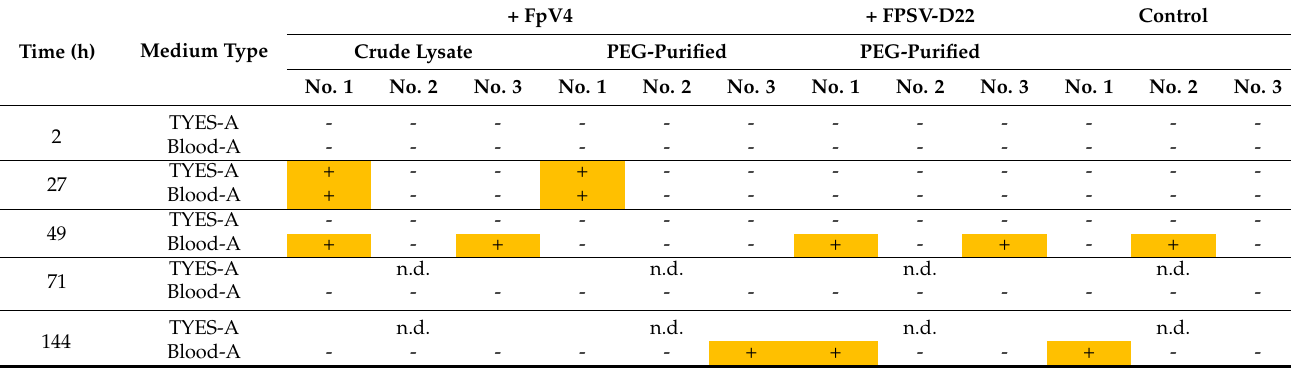
Table A3. Exp. I section B. Bacterial growth in the well of sampled eyed eggs was assessed during the experiment. A plus symbol with an orange background indicates a positive detection of bacterial colonies in TYES-B and/or on Blood-A (“-” = no growth). F. psychrophilum was not detected.